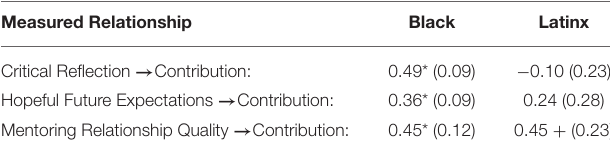
TABLE 2 | Heterogeneity of effects by ethnic-racial